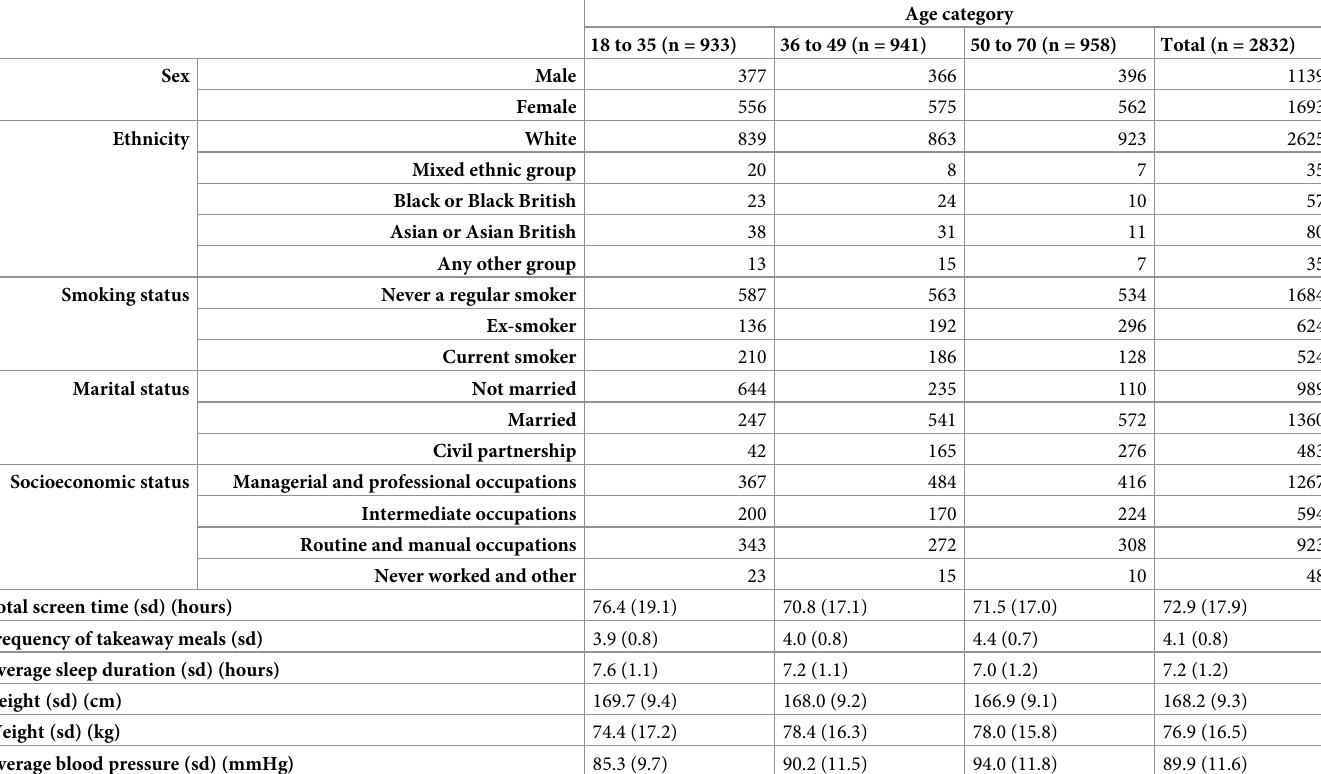
Table 1. Descriptive statistics of the study population, grouped by age. Only age, sex, height and weight were ultimately used in the machine learning models as predic- tive variables. All variables were, however, used for imputing missing data and constructing synthetic